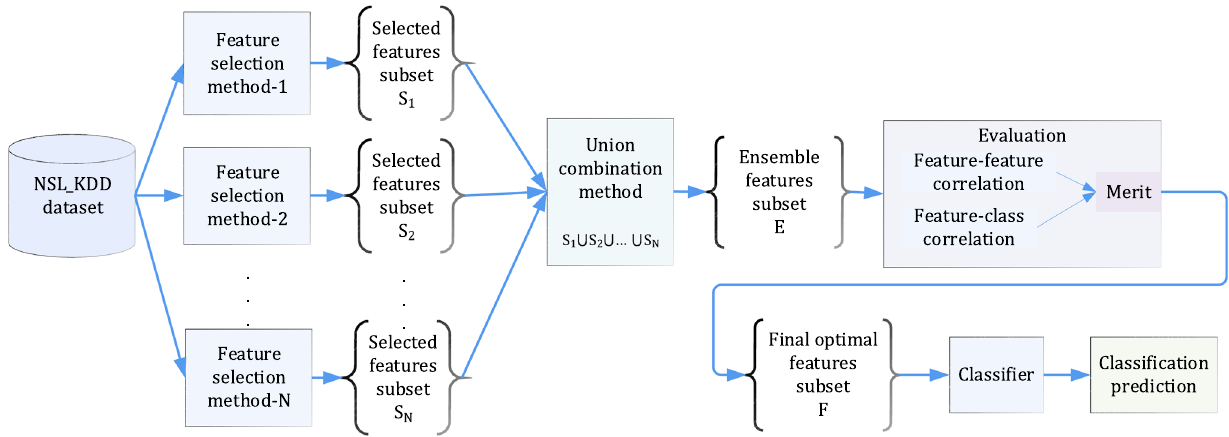
Fig. 1 The scheme of the proposed